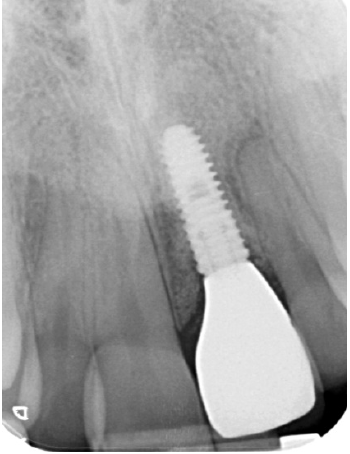
Figure 19. Radiographic evaluation 1 year after CTG.